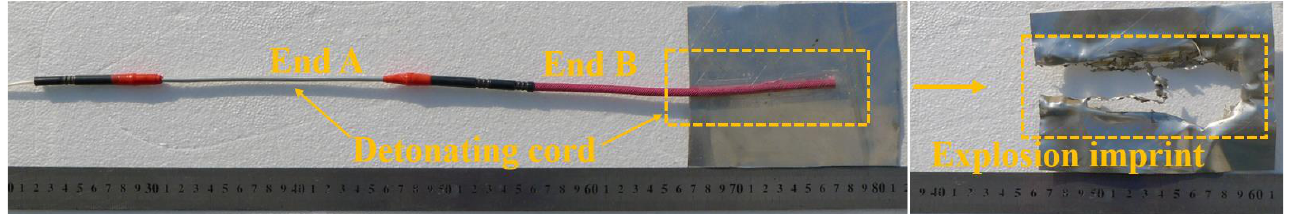
Figure 7. Failed explosion-proof experiments.